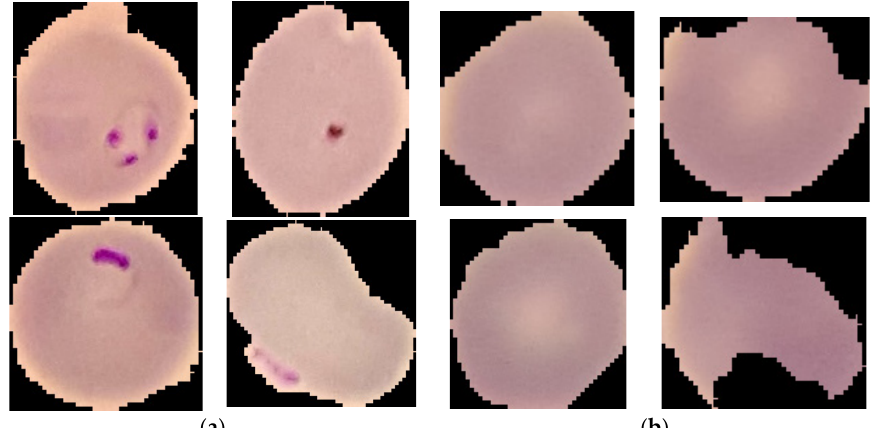
Figure 1. Some of the parasitized and uninfected images. ( a ) Parasitized images; ( b ) uninfected images.